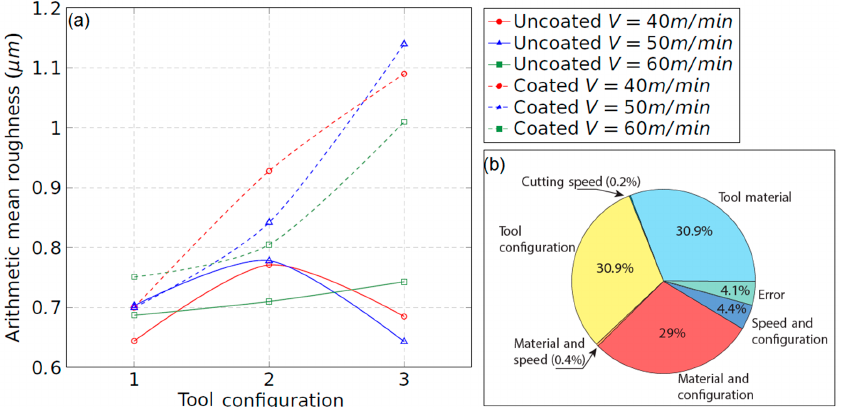
Figure 14. ( a ) Arithmetic mean roughness of the machined surface vs. tool configuration; ( b ) contri- bution of each parameter on surface roughness obtained from an ANOVA analysis. For the uncoated tool, no correlation of Ra with the tool configuration was found. Conversely, the coated tool shows worse behaviour that is clearly influenced by the tool